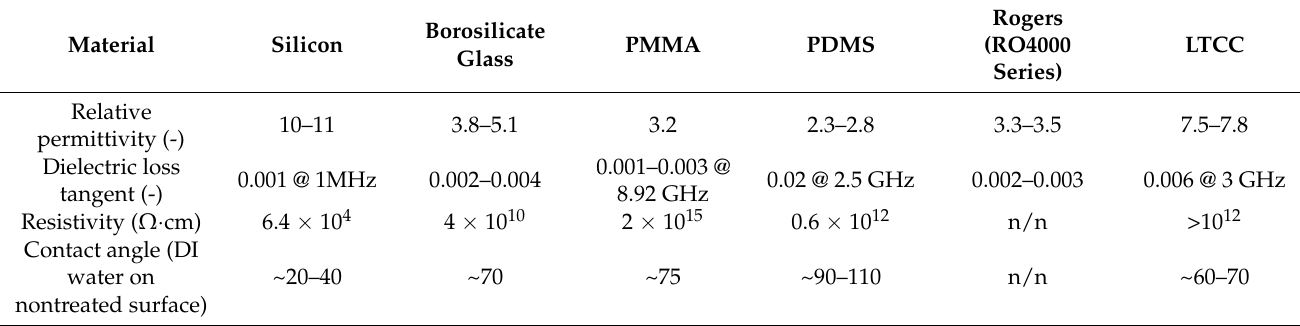
Table 1. The selected properties of the materials that act as substrates for microfluidic or/and microwave components in the microfluidic-microwave devices. Based on